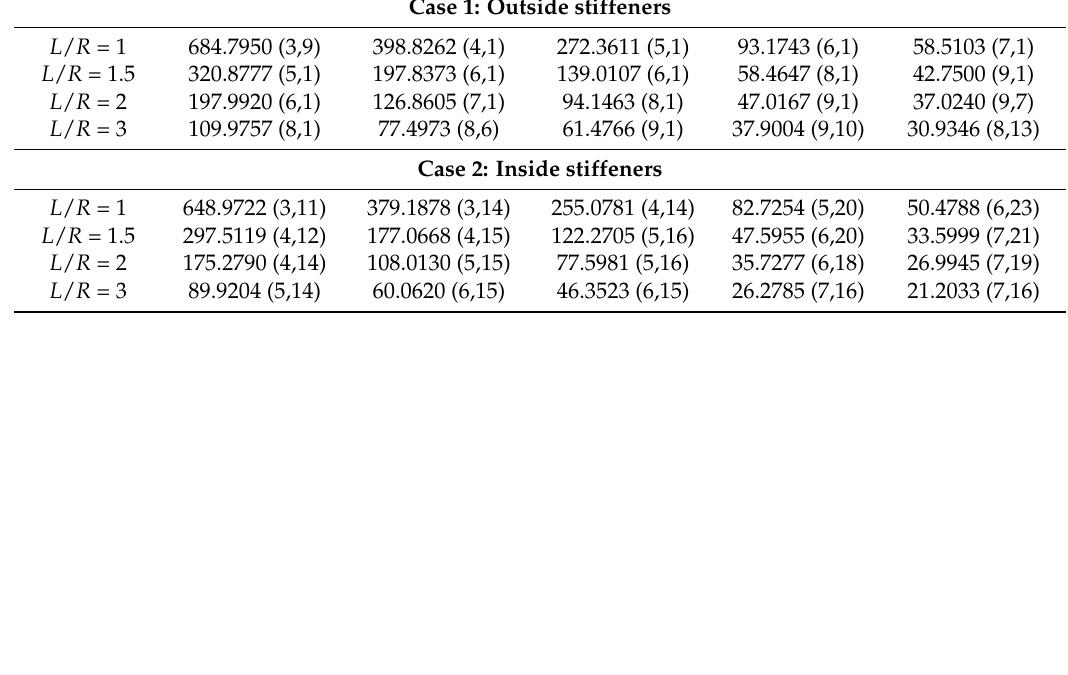
Table 7. Critical compression load